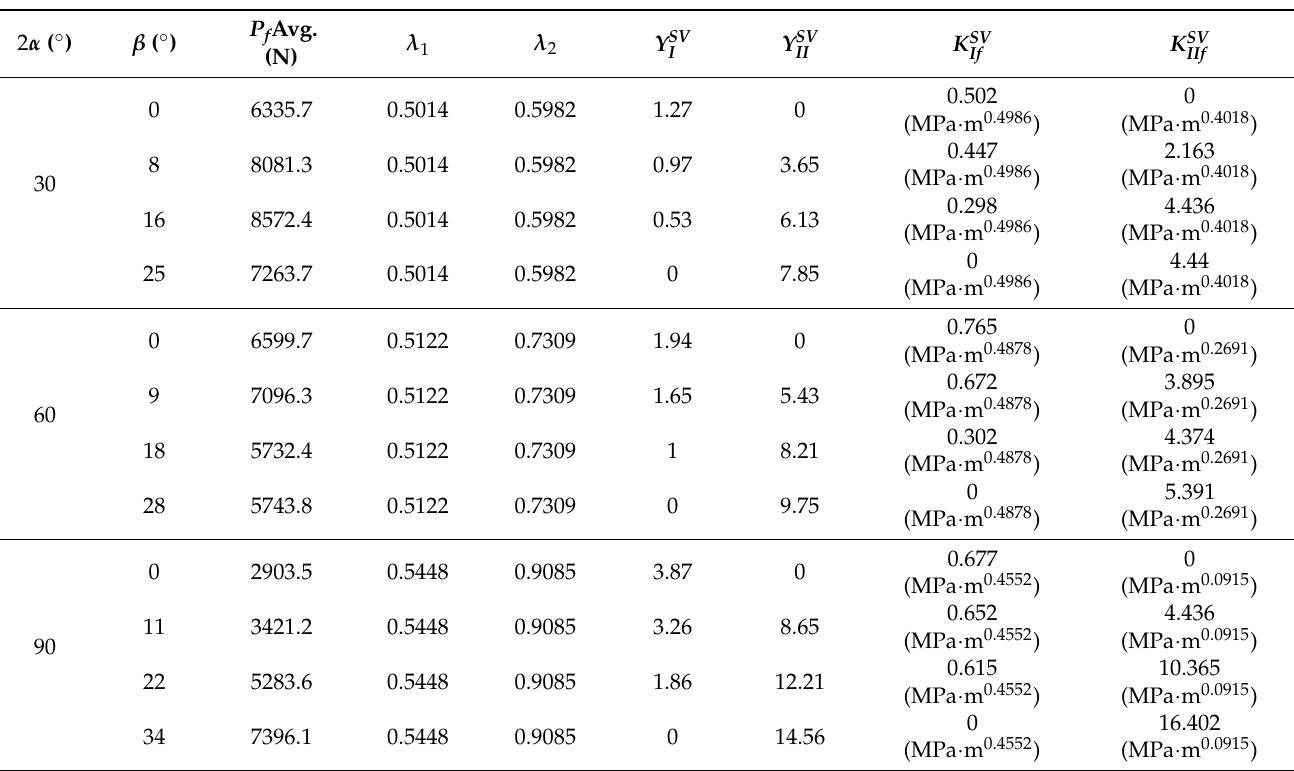
Table 2. Eigenvalues λ 1 and λ 2 , dimensionless parameters Y SV